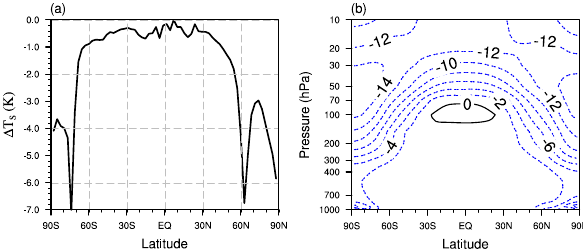
Fig. 9. Changes of annual- and zonal-man (a) surface temperature and (b) air temperature between the 50% Lower WBD scenario and the control experiment. The CO 2 level is